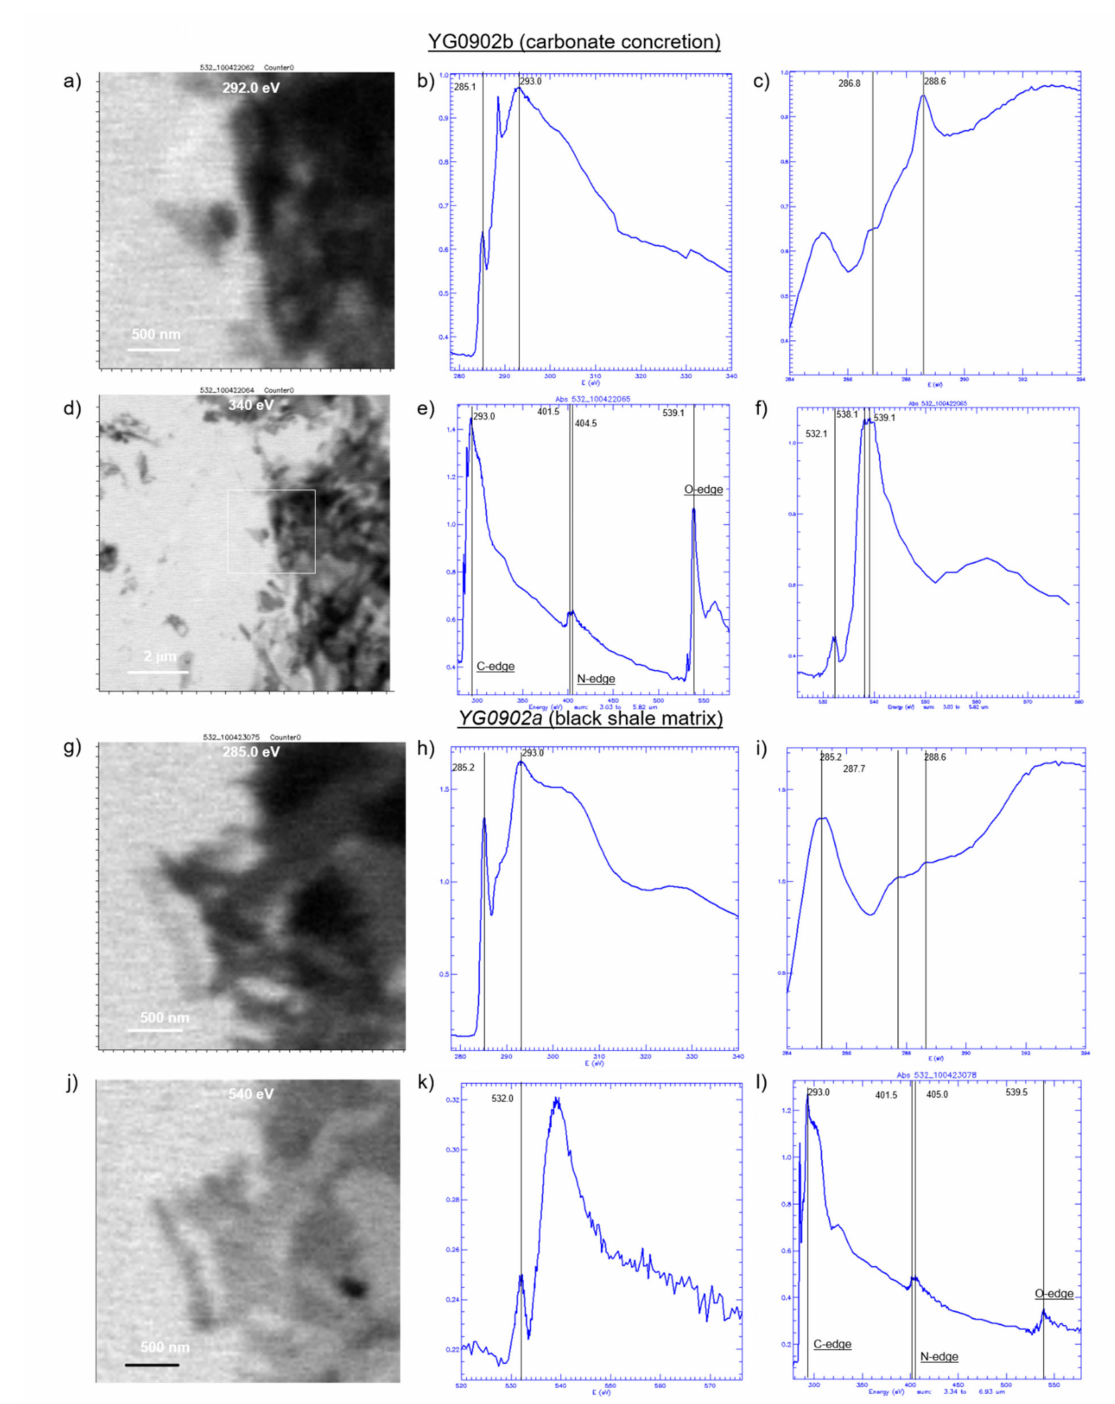
Figure 8. X-ray images and spectra of organic matter extracted from Niutitang black shale. For the carbonate concretion: ( a ) STXM image at 292.0 eV showing strong absorption of light by the organic matter. ( b ) C-EXAFS region with the two main edge peaks at 285.3 and 293.0 eV, ( c ) C-XANES spectrum with two resolvable peaks identified at 286.8 and 288.6 eV from molecular groups, ( d ) image at 340 eV showing a variety of contrast in the organic matter, ( e ) full X-ray spectrum covering the range of the C, N, and O edges, and ( f ) O-XANES spectrum, which shows three resolvable peaks. For the black shale matrix: ( g ) STXM image of organic matter at 285.0 eV, ( h ) C-EXAFS region with the same two main peaks as before, ( i ) C-XANES spectrum that shows a depressed region with two resolvable peaks at 287.7 and 288.6 eV, ( j ) STXM image at 540 eV showing at least three different contrast levels of gray shades, ( k ) O-XANES spectrums showing a peak at 532.0 eV, and ( l ) full X-ray absorption spectrum over the range of energies for the C, N, and O